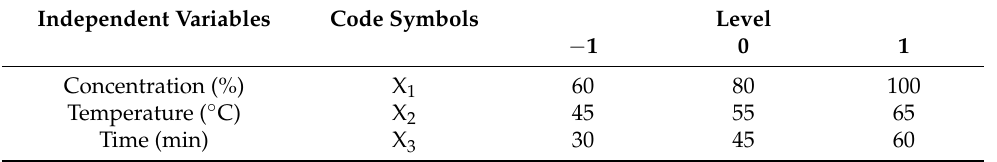
Table 1. The values for the Box–Behnken design (BBD). Independent Variables